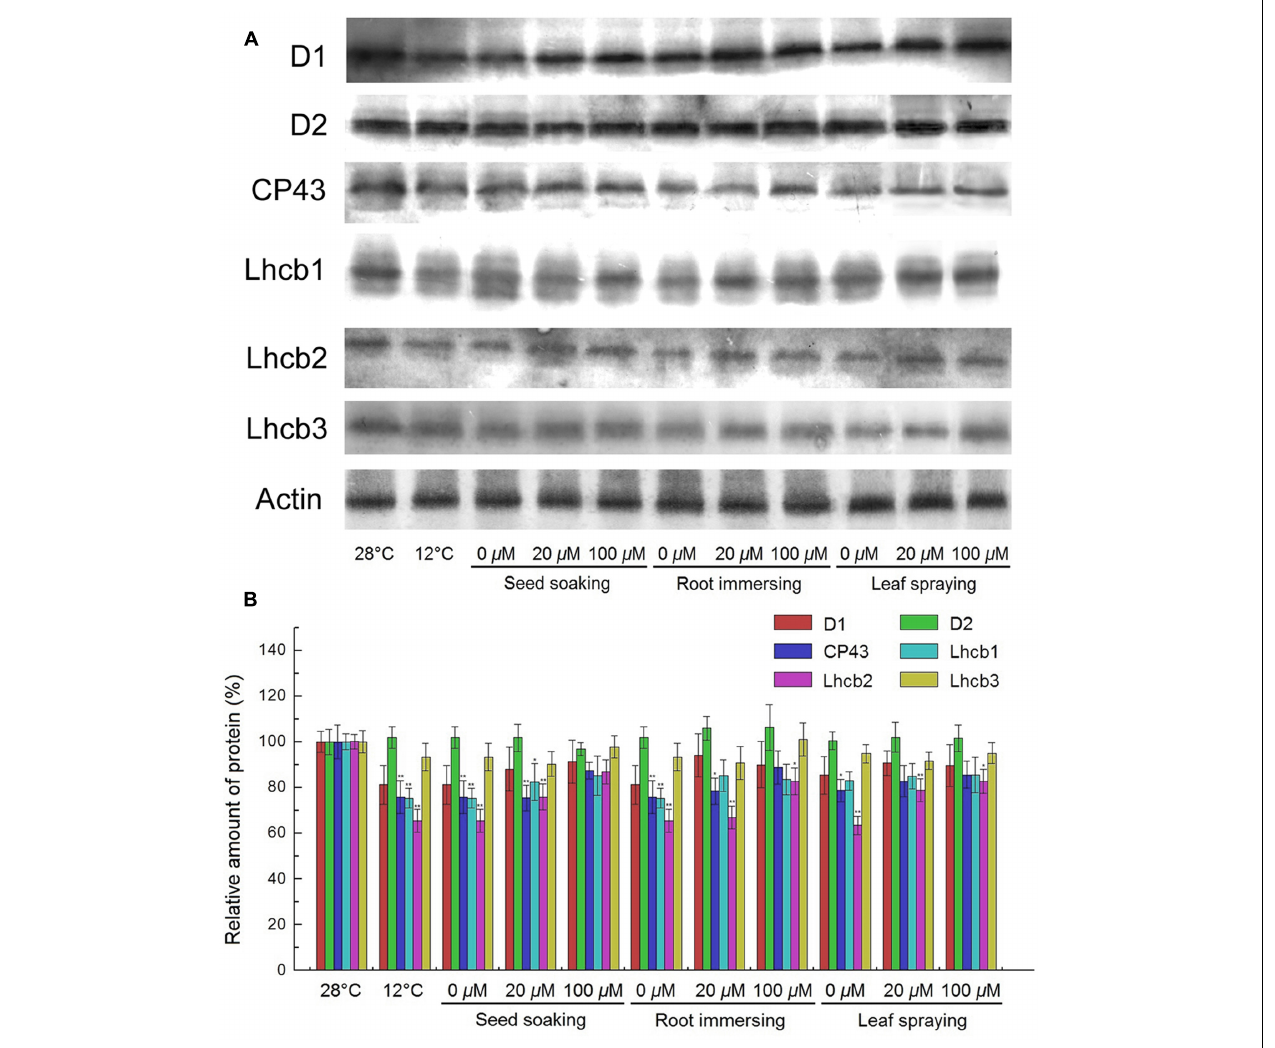
FIGURE 8 | Effects of exogenous melatonin on thylakoid membrane proteins. (A) Immunoblotting was performed with antibodies against D1, D2, CP43, Lhcb1, Lhcb2, Lhcb3 and Actin conserved peptide. Loading was according to an equal amount of chlorophyll. Results by SDS-PAGE after blue staining (CBS) are shown in the bottom panel. (B) The quantification of immunoblot data. Results are relative to the amount in the 28 ◦ C (100%). ∗ , ∗∗ indicate statistically significant differences at P < 0.05 and P < 0.01, respectively, determined using Duncan’s multiple range test. Others are the same as in Figure 1